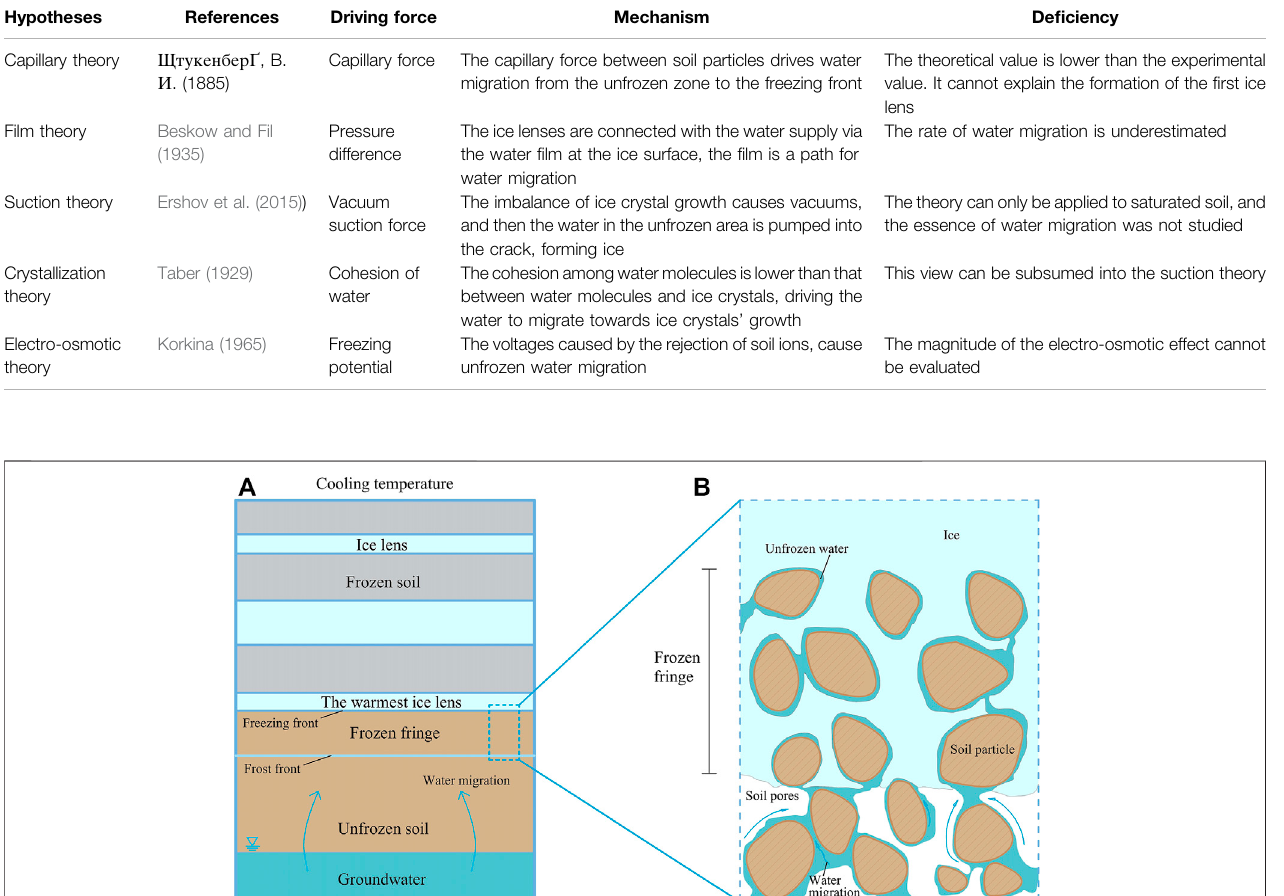
Frontiers in Earth Science |